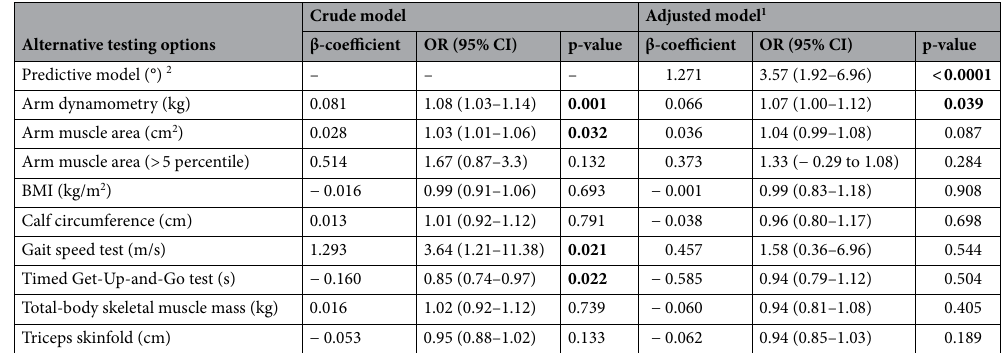
Table 2. Logistic regression models on the association between adequate muscle mass according to alternative tests and BIVA. Significant values are in bold. 1 Adjusted for age as a potential confounder on the prostate cancer—muscle wasting association. 2 The equation includes age as a predictive variable.